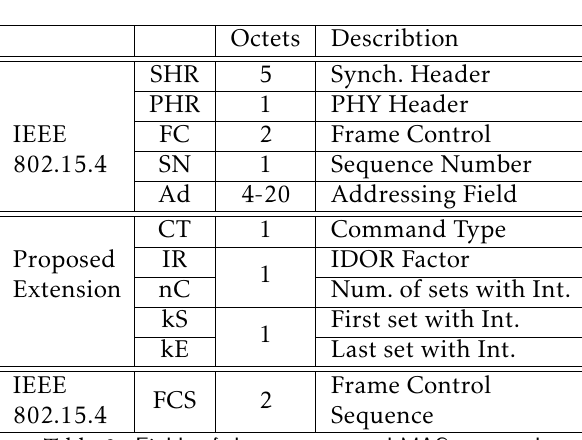
Table 2. Fields of the new proposed MAC command